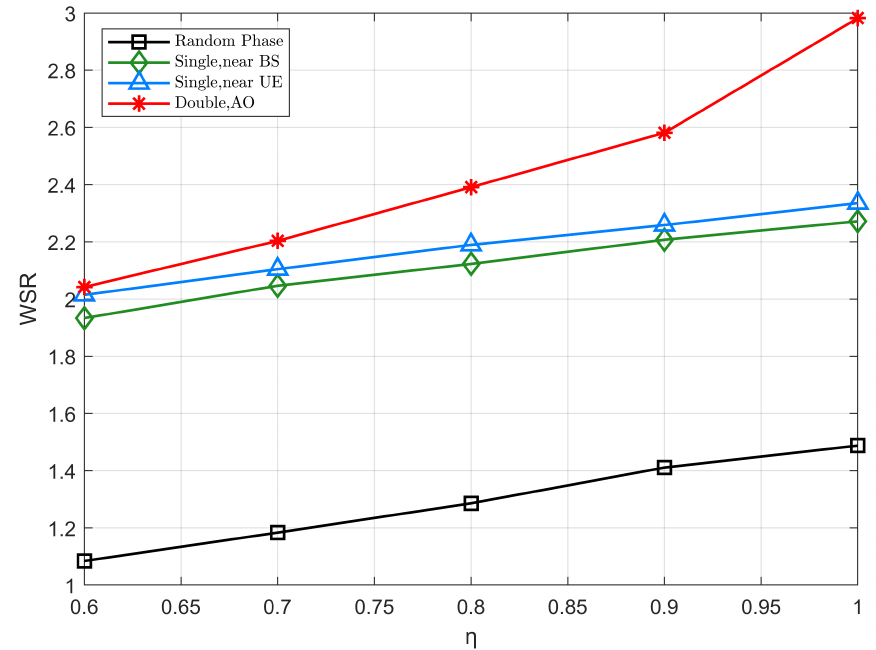
Figure 8. The WSR versus the number of transmit antennas M at the BS.